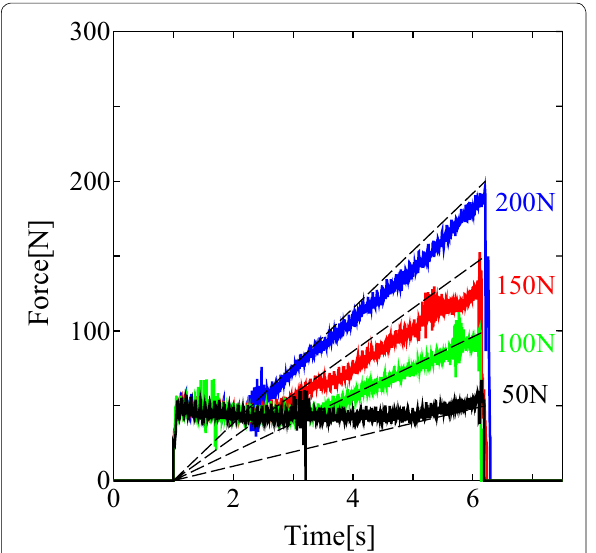
Fig. 17 Results of isokinetic exercises